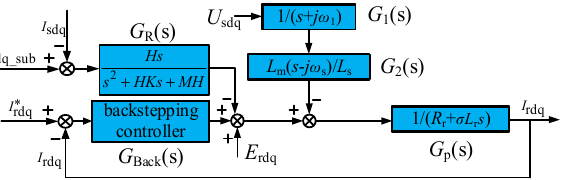
Figure 6. Block diagram of the rotor current vector control embedded in the adaptive quasi-resonant and back-stepping controller.